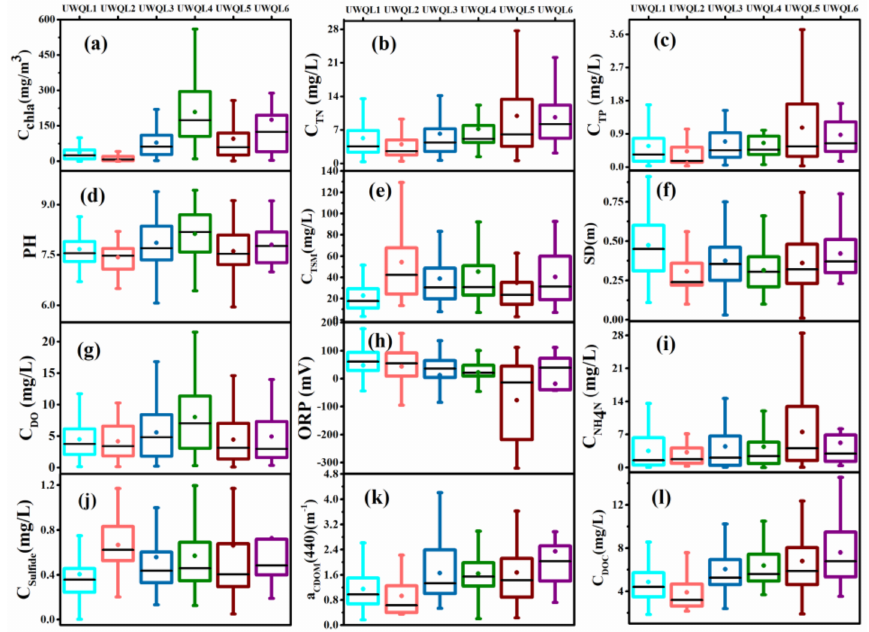
Figure 5. Boxplots for Chla, TN, TP, TSM, NH 4 -N, sulfide, DOC concentration, pH, SD, DO concen- tration, ORP, and a CDOM(440) across six UWQLs ( a – l